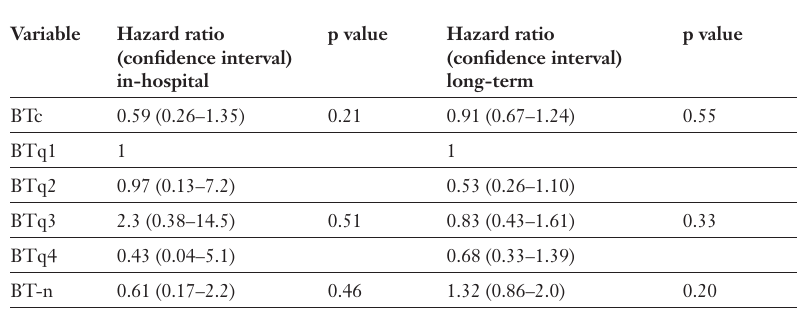
Multivariate cox re- gression analysis for in-hospital and long- term cardiovascular mortality with BT en- tered as a continuous variable (BTc), quar- tiles of BT